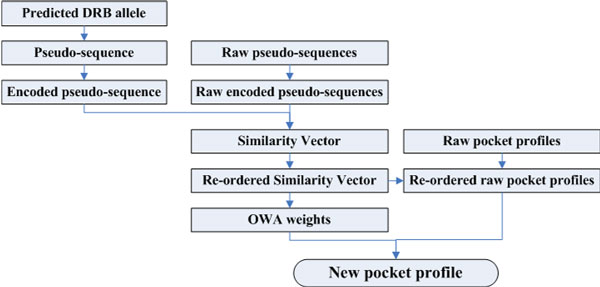
Schematic illustration of profile generation for pocket 4/6/7/9.